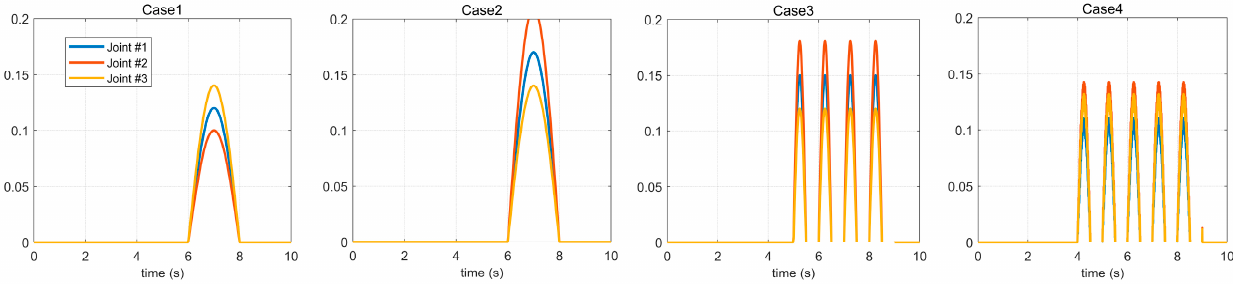
Figure 4. External disturbances in the four cases.